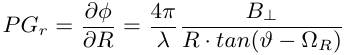
Figure 2. Common interaction of SAR L- and C-bands with the forest structure (Omar et al., 2017) are full polarimetric, which means the information is available for the VV, VH, HV and HH polarization channels.